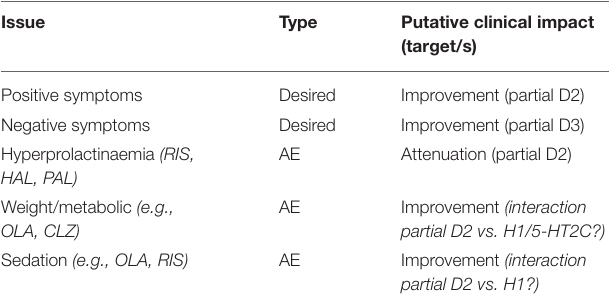
TABLE 5 | Summary of putative clinical impact of APP treatment involving partial agonists. Issue